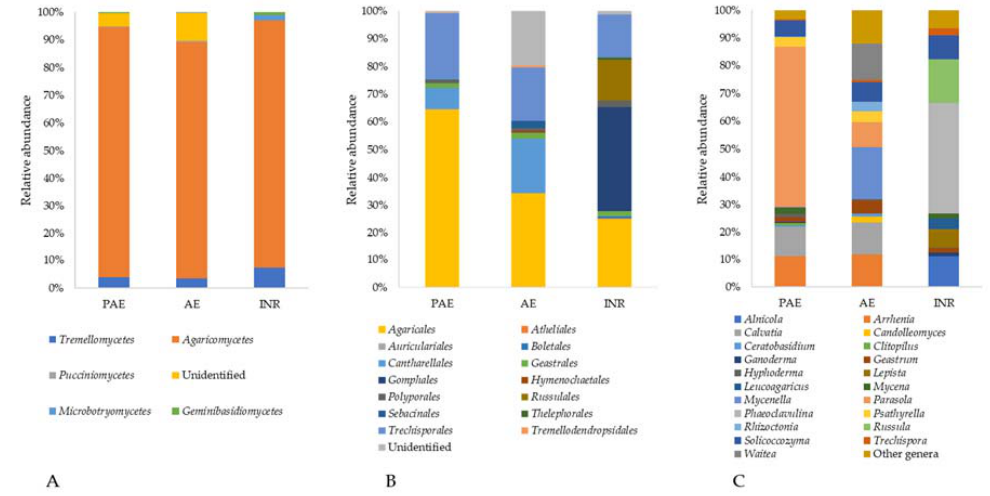
Figure 5. Relative abundances of Basidiomycota classes ( A ), of orders within Agaricomycetes ( B ), and most abundant genera ( C ) in soil samples taken from the Polluted AgroEcosystem (PAE), the AgroEcosystem (AE), and the integral natural reserve (INR).